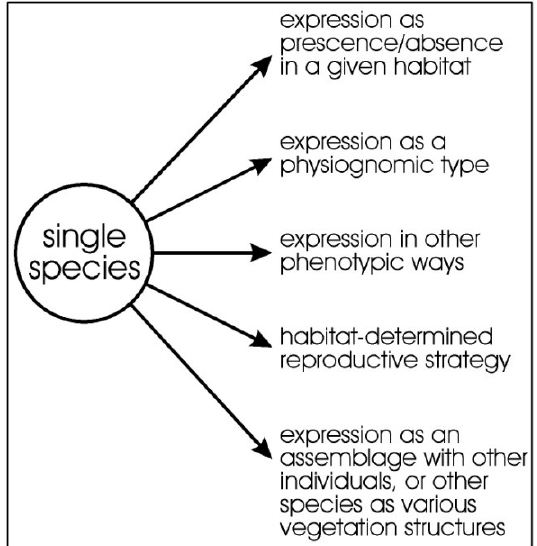
Figure 1. Idealised diagram showing how the pressures on a species drawn from the regional species pool and how the environment can select for species presence/absence, determine its expression physiognomically and other ways phenotypically, and together with other individuals of the species, or from other species, can generate floristic occurrence, physiognomy, vegetation structures, and